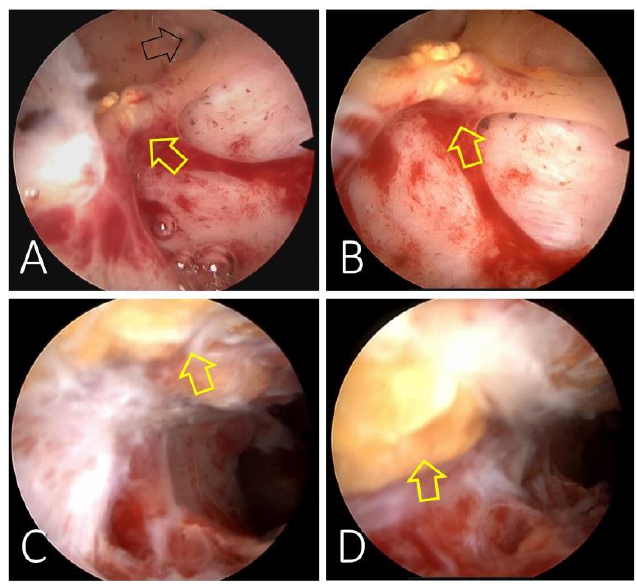
Figure 3. Hysteroscopic evaluation of the uterine cavity at two weeks after the curettage. A band with a fibro-lipomatous appearance (yellow arrows) is identified running from the uterine fundus, next to the tubal ostium ( A ), continuing through the entire endometrial cavity ( B ) to the cervical canal ( C , D ).